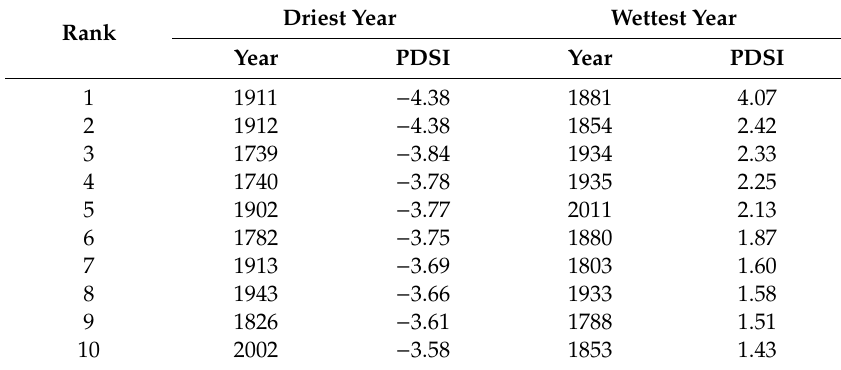
Figure 6. Spatial correlations between the PDSI reconstruction and ( A ) June mean precipitation and ( B ) actual PDSI from the Climate Research Unit,CRU TS4.02 data (1965–2016) ( p < 0.01).